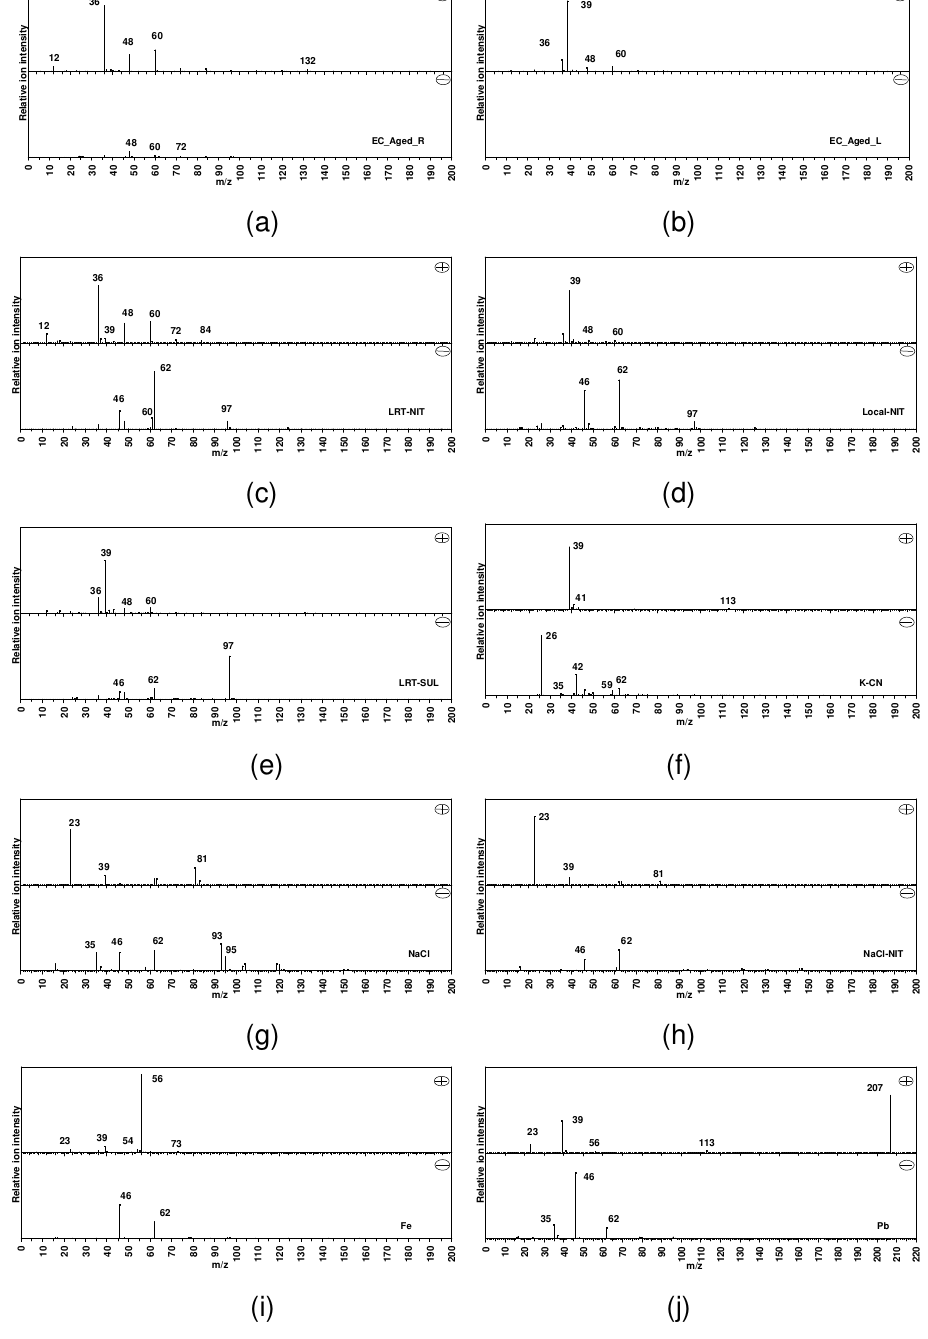
freshly emitted. Indeed, Giorio et al. (2012) reported for a regional background site that strong EC peaks in the neg- ative ion mass spectrum are more indicative of fresh emis- sions while strong EC peaks in the positive mode represent aged EC. This is consistent with observations which indi- cate that particle composition affects the ionization and